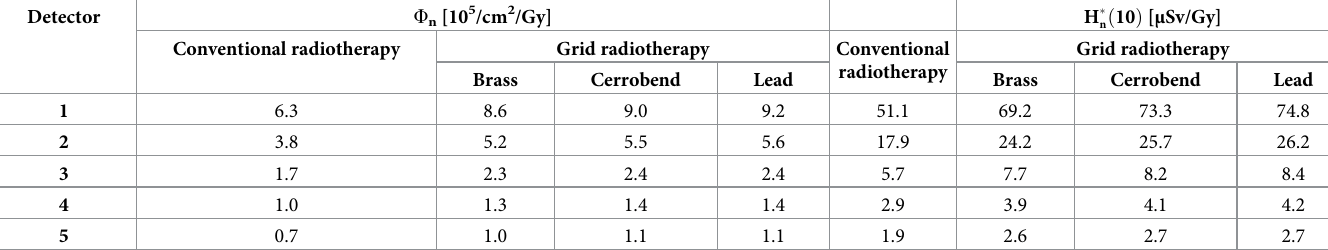
(10)) inside the maze in 15 MV radiotherapy. n